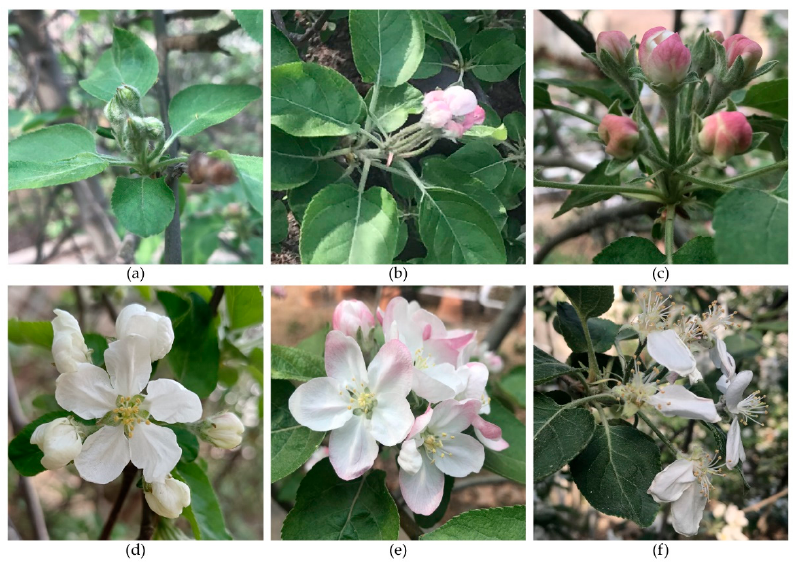
Figure 1. Apple flower blooming level. ( a ) Spitting Buds (SB); ( b ) Tight Clusters (TC); ( c ) Balloon Blossom (BB); ( d ) King Bloom (KB); ( e ) Full Bloom (FB); ( f ) Petal Fall